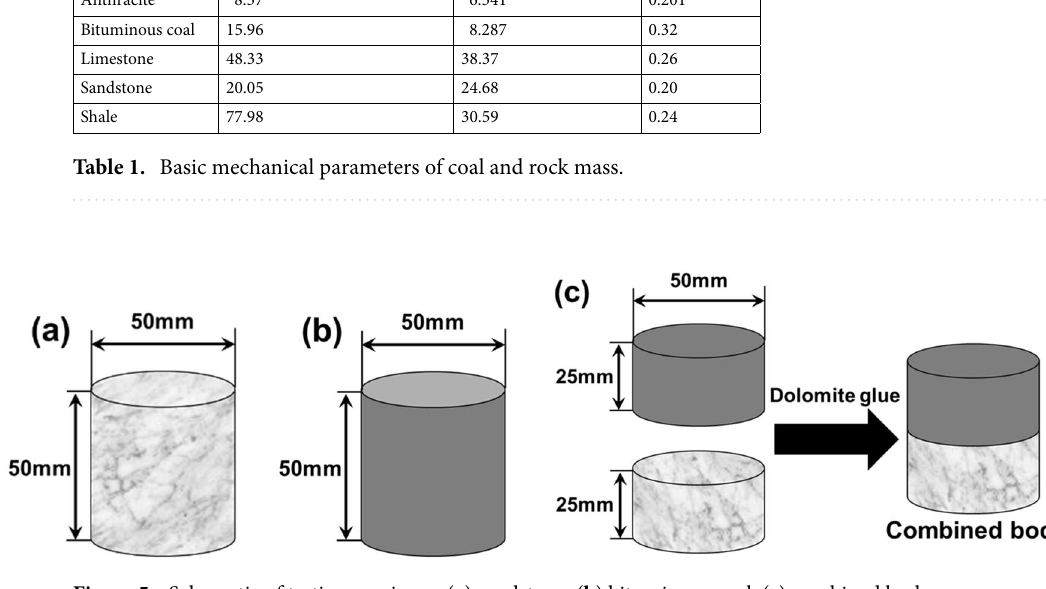
Figure 5. Schematic of testing specimen. ( a ) sandstone, ( b ) bituminous coal, ( c ) combined body.